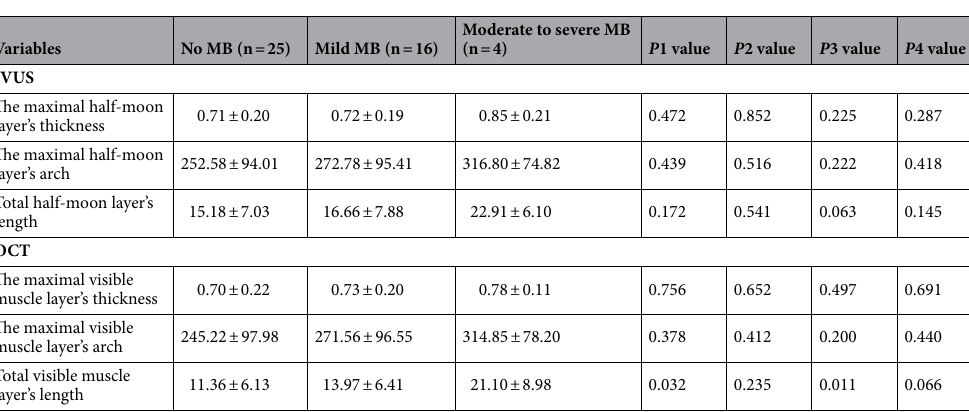
Table 1. IVUS and OCT characteristics about MB among no MB, mild MB, and moderate to severe MB groups according to coronary angiography. Data were expressed as n (%), mean ± SD. Variance analysis, P1; Mild MB vs. No MB, P2; Moderate or severe MB vs. No MB, P3; Moderate or severe MB vs Mild MB, P4. IVUS intravascular ultrasound, OCT optical coherence tomography, MB myocardial bridge.